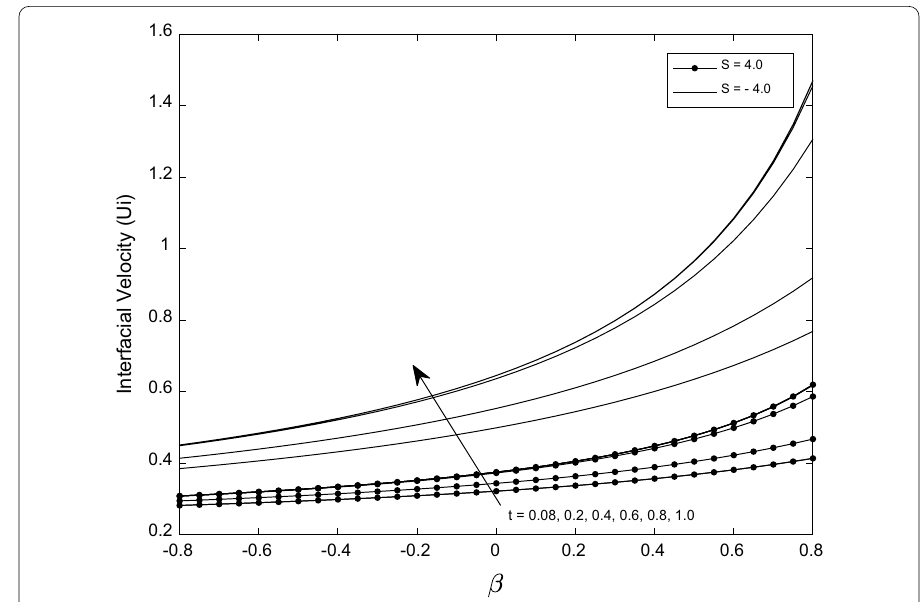
0.2, P 10,Da 0.2, d 1.5, A ∗ 1, w 0.8 ) = = = = = =